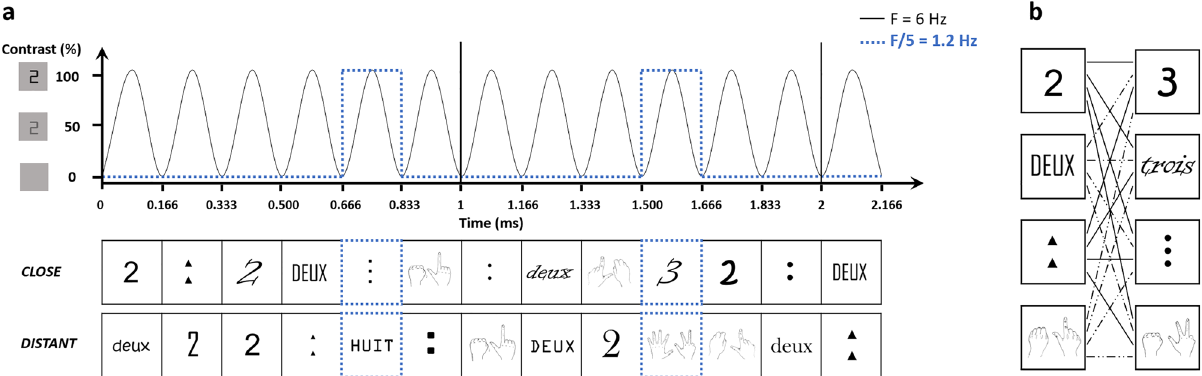
Figure 1. ( a ) EEG experimental design. Two numerosities were presented in randomly mixed codes (digit, word, dots, fingers) at a constant frequency of 6 Hz (i.e., 6 stimuli per second): a base numerosity (for instance “2”) and a deviant numerosity (for instance “3” in the close condition and “8” in the distant condition) which appeared every fifth base stimuli (i.e., at 6 Hz/5 = 1.2 Hz, highlighted in blue). ( b ) Behavioral task design. Participants had to choose the smaller/larger of two numerosities (for instance the close pair “2/3”) presented in every possible code (digit, word, dots, fingers). Note: “deux” means “two” in French, “trois” means “three” and “huit” means